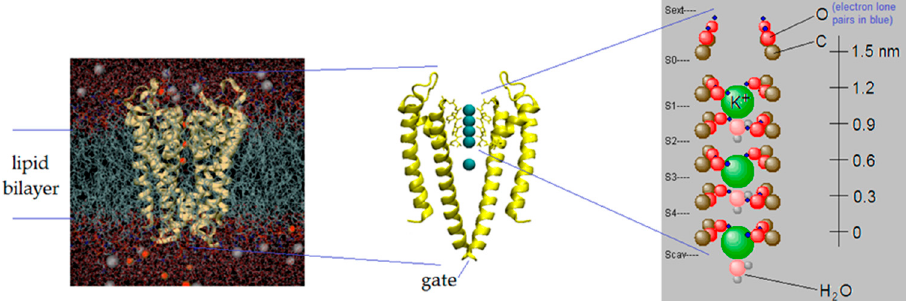
Figure 1. A ribbon model K + channel embedded in the lipid bilayer ( left ), with two of the four subunits and the extracellular side on top ( middle ). The four binding sites (S1–S4) with four dehydrated ions in locations S1 and S3, and one partially dehydrated ion in the neighboring cavity location S cav , are demonstrated ( right ). Ions are kept in green color, water is shown in pink, carbonyl oxygens in red, and backbone carbon atoms in brown color. Lone pair electrons attached to oxygens are indicated by blue dots. The close-up view on the right side sketches the relative sizes of particles, which are assumed to be as follows: ion radius of K + = 138 pm; covalent radius of carbon (when in double bond with O) = 64.1 pm; covalent radius of oxygen (when in double bond with C) = 58.9 pm; center–center distance of C and O-atoms in carbonyls = 123 pm; H 2 O: covalent radius of O-atoms 73 pm; bond radius of H-atoms = 38 pm; center–center distance between O and H = 95.84 pm.